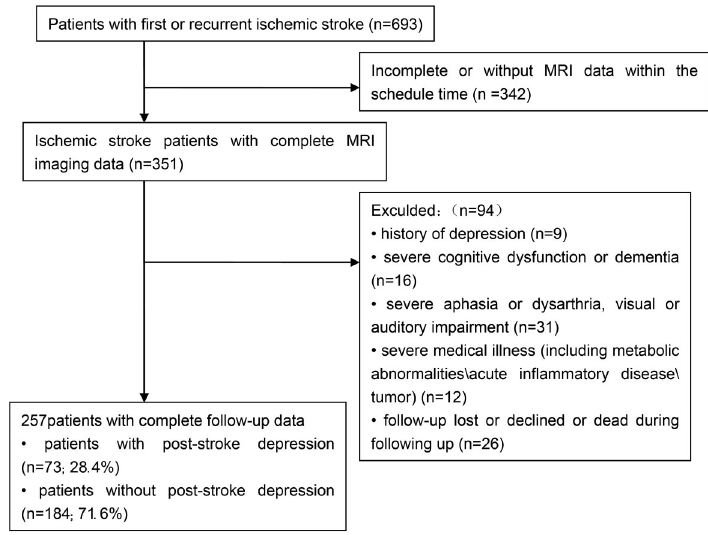
Figure 1. Study recruitment pro fi le.